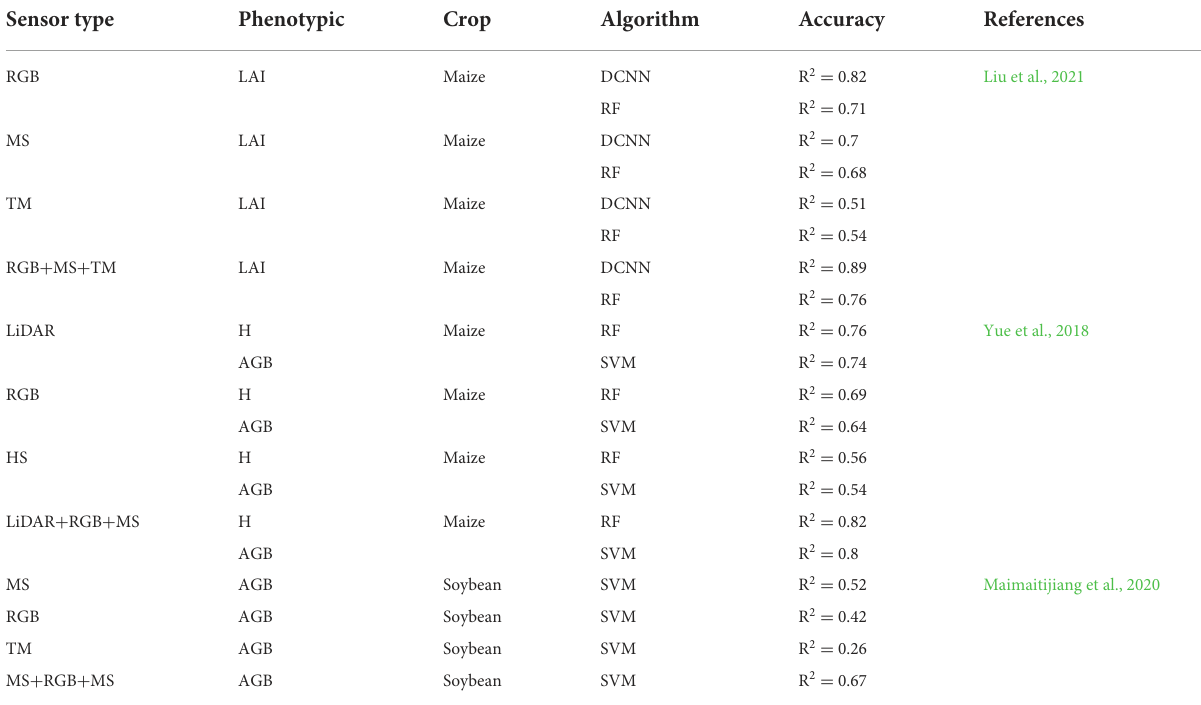
TABLE 1 Results of estimating relevant indexes of field crops using multi-source remote sensing data. Sensor